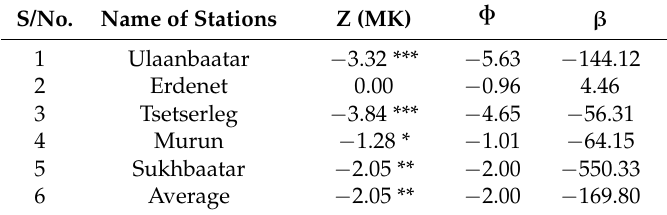
Table 4. The result of Z-statistic of MK, ITAM ( ф ), and Sen’s slope estimator test ( β ). S/No. Name of